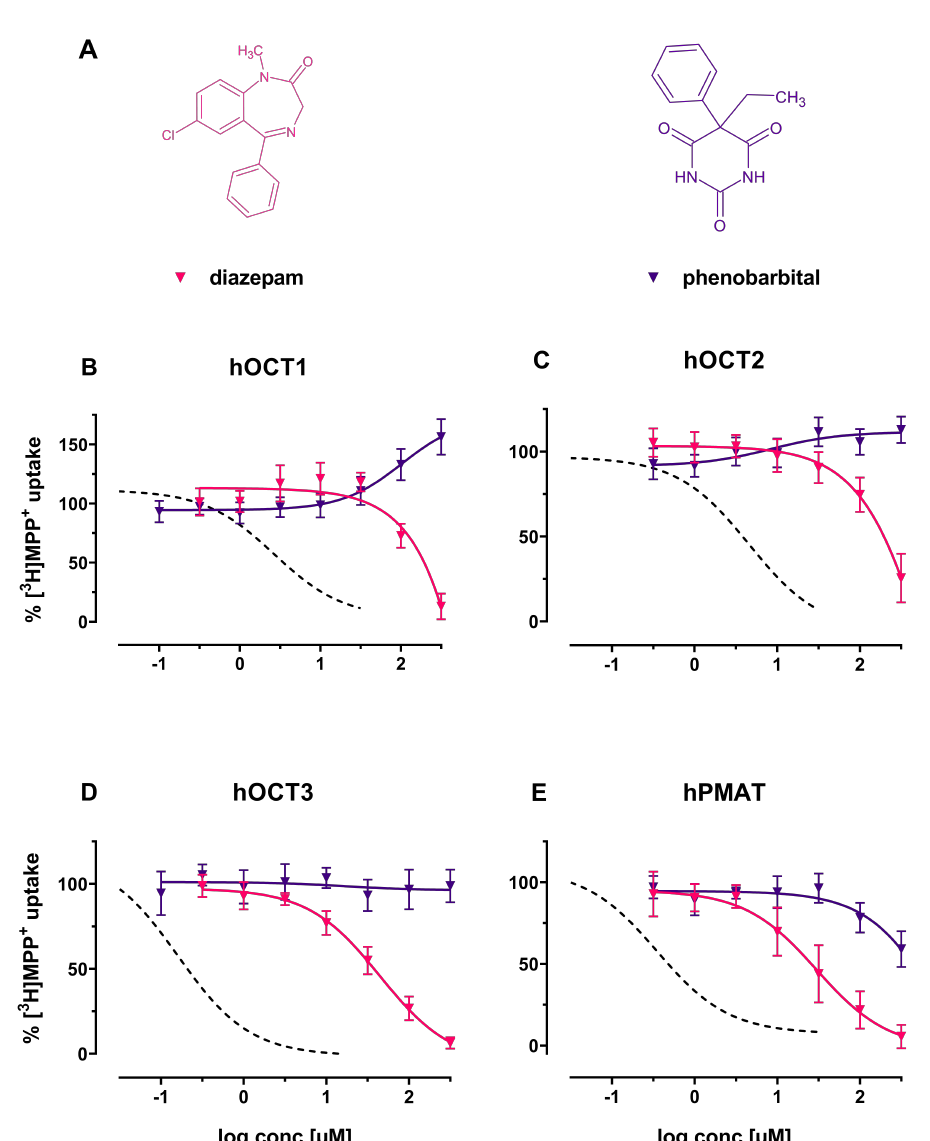
Figure 3. ( A ) Chemical structures of the herein investigated antiepileptics diazepam (red) and phenobarbital (violet); ( B – E ): Effects of the above-mentioned compounds (including decynium-22; dashed line) on ( B ) hOCT1, ( C ) hOCT2, ( D ) hOCT3 and ( E ) hPMAT of uptake of tritiated MPP + in HEK293 cells stably expressing the respective